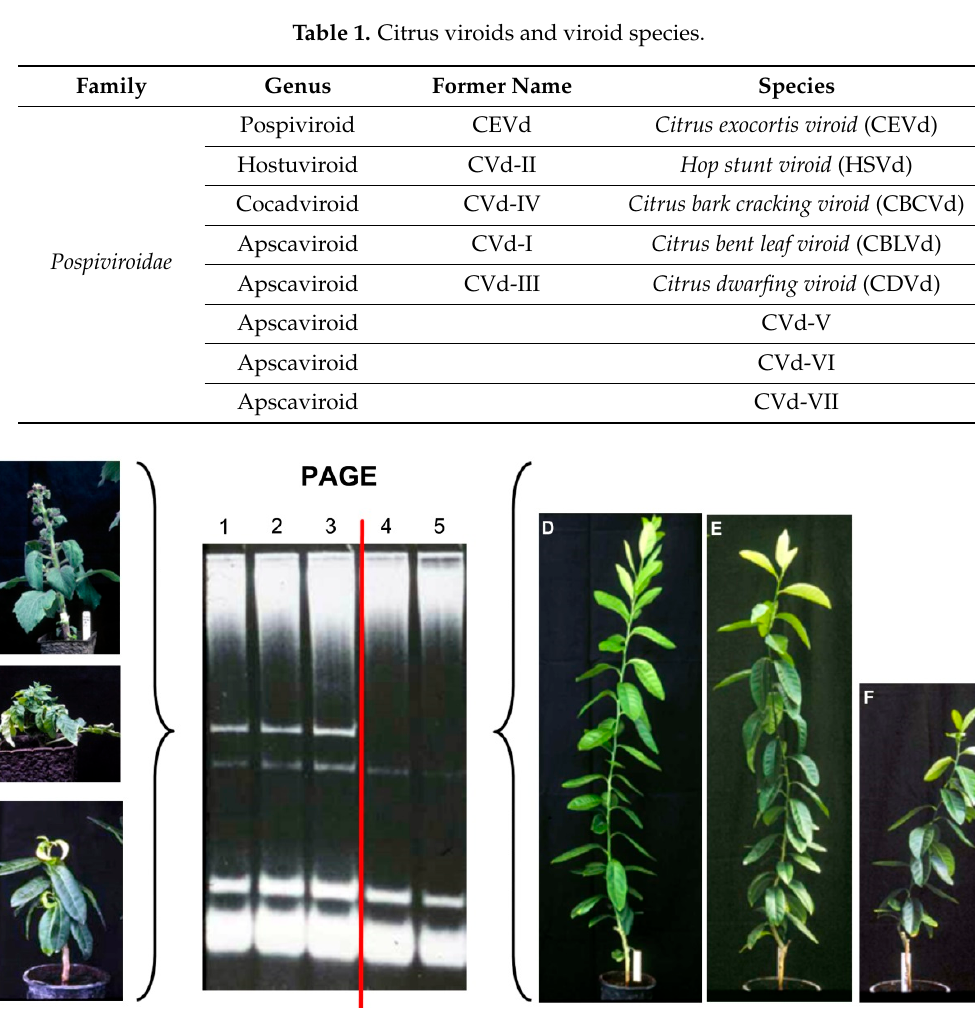
Figure 1. Analysis of different inoculated hosts by polyacrilamide gel electrophoresis (PAGE) and ethidium bromide staining. A characteristic band corresponding to a viroid RNA was stained in samples (1–3) from Gynura aurantiaca ( A ), tomato ( B ), and Etrog citron showing severe symptoms, whereas the same band was not observed in samples (4,5) from Etrog citron plants displaying mild and moderate symptoms ( D–F ).